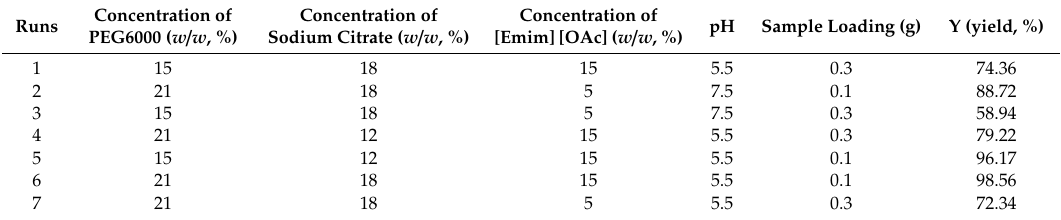
Table 2. (Y) Capsaicin in TAPPIR technology using fractional factorial